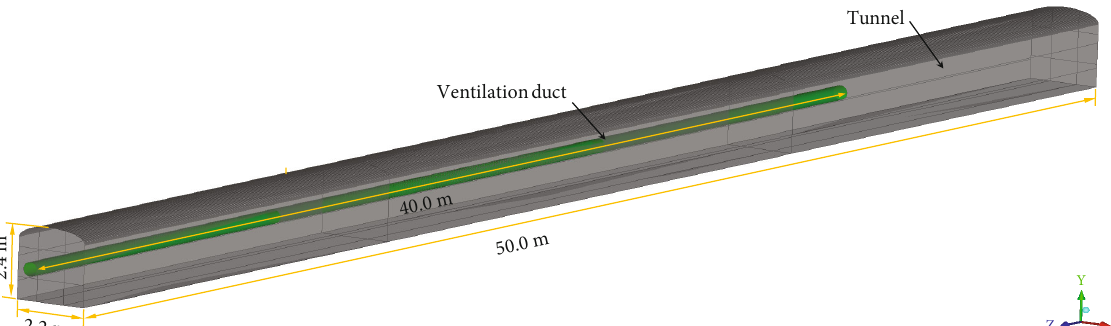
Figure 2: The -870 m horizontal tunnel geometric model.